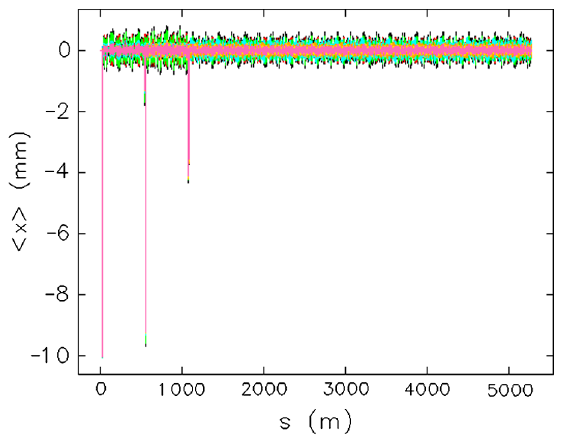
FIG. 23. The horizontal trajectory of the stored beam centroid during ten turns passing through the low field ring. The errors of the injection kickers have been included. Colors represent the number of the error seeds.